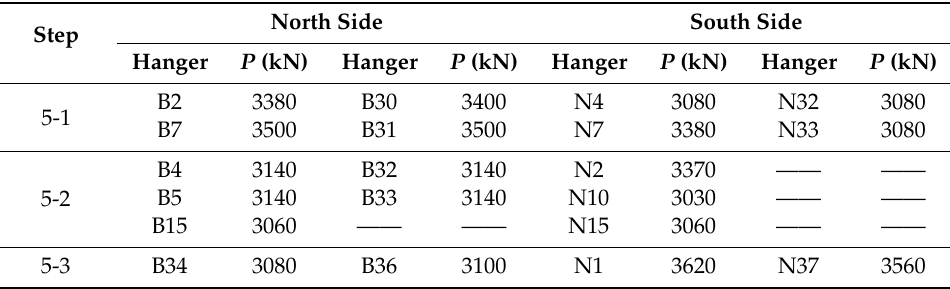
Table 9. Specific step and control parameter of tensioning round 5.